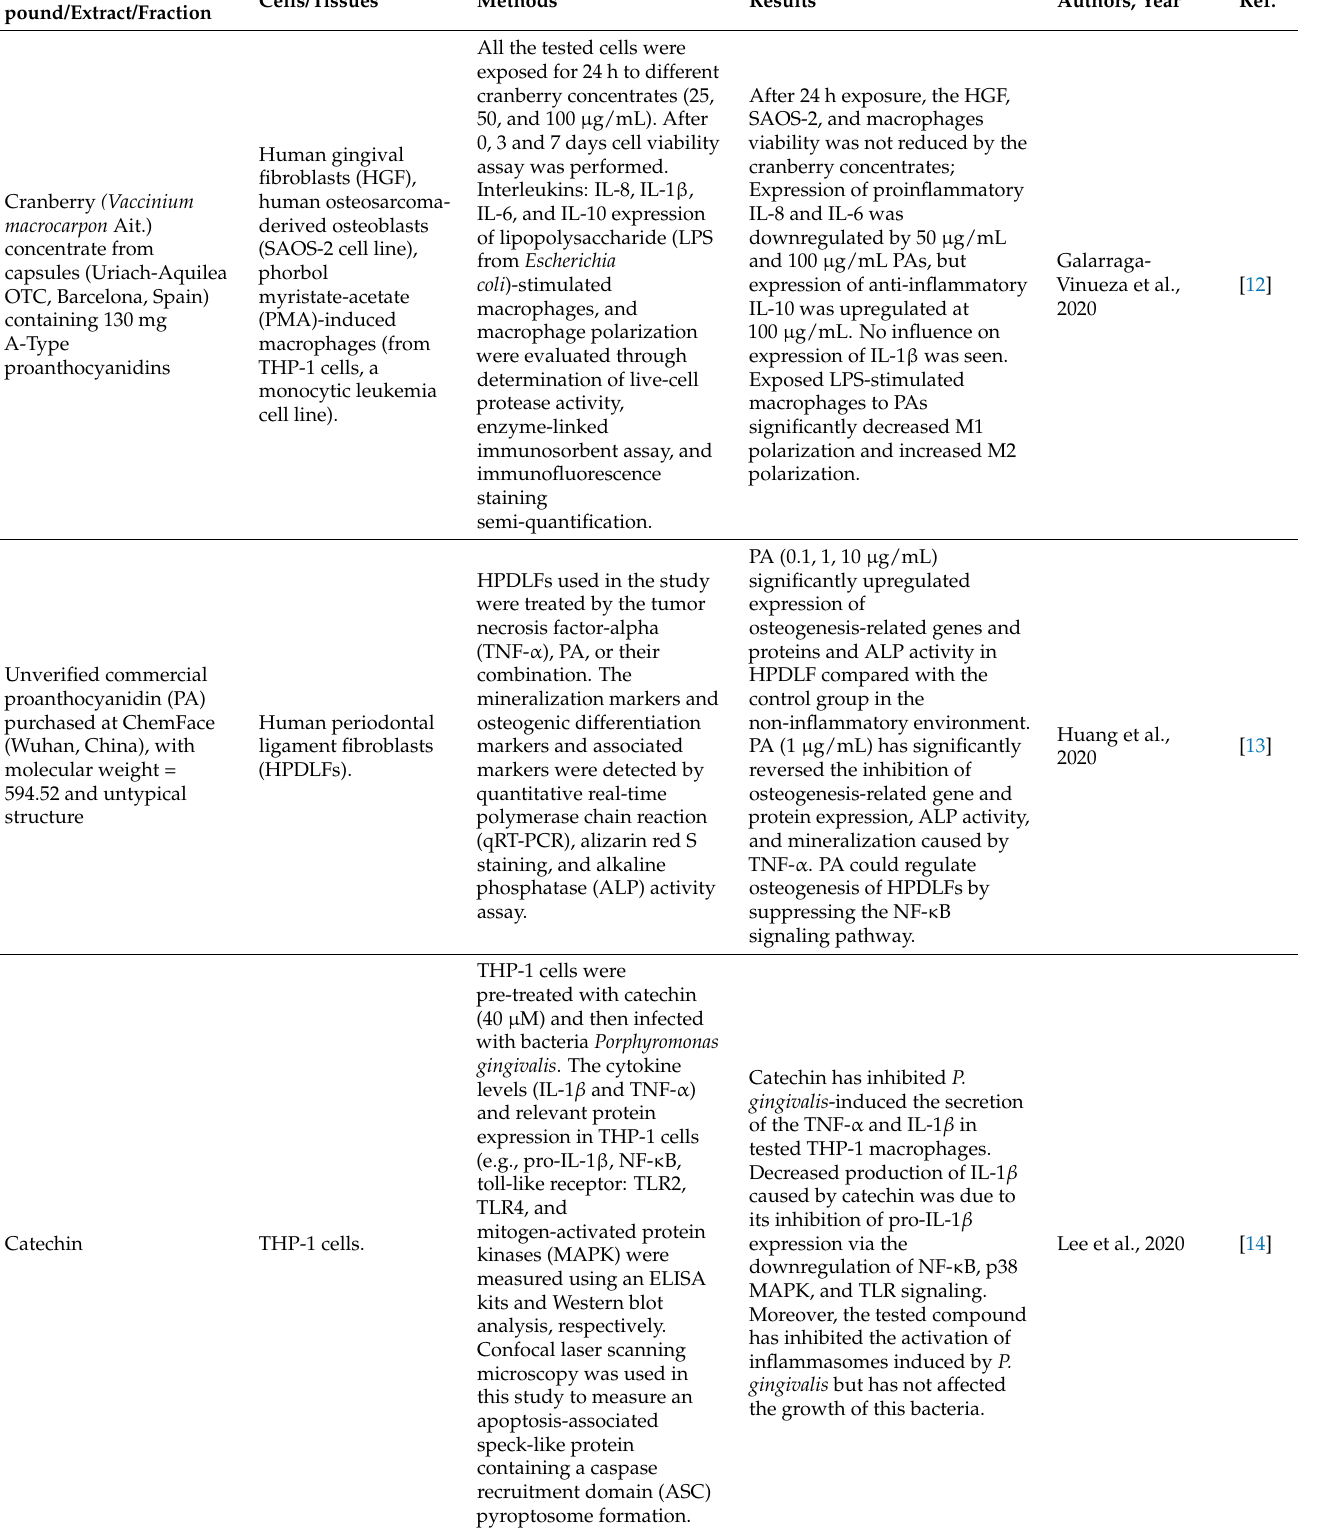
Table 1. Immunomodulatory effects of proanthocyanidins (PAs) or flavan-3-ols on host cells and tissues—in vitro studies. Active Com- pound/Extract/Fraction